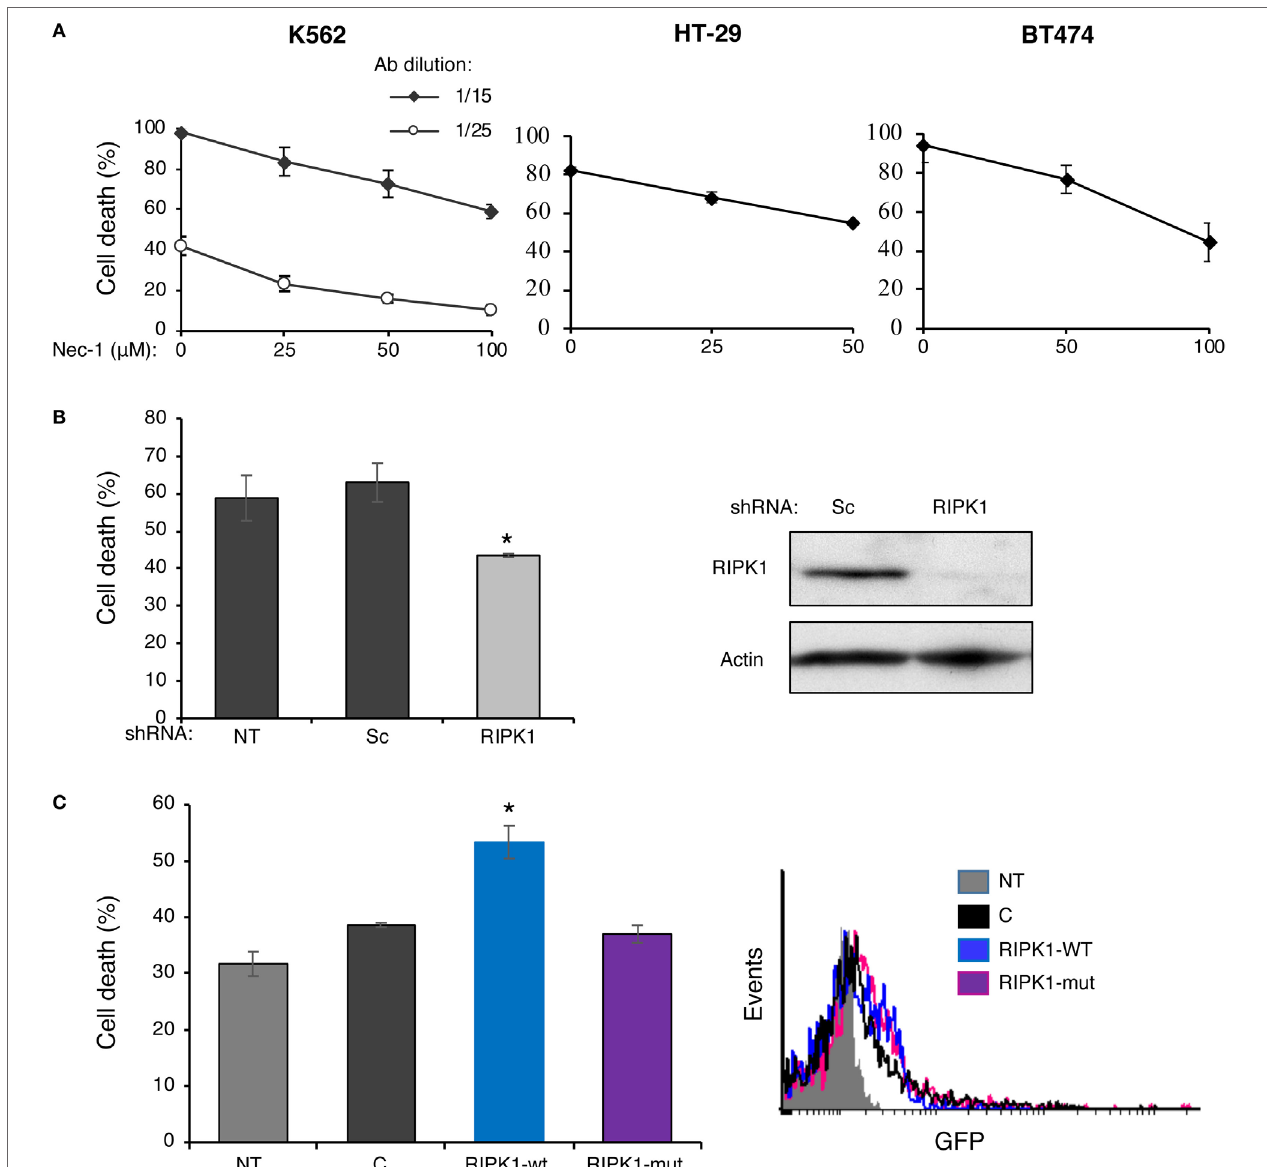
FigUre 1 | Complement C5b-9 induces receptor-interacting protein kinase 1 (RIPK1)-dependent necrosis. (a) K562, HT-29, or BT474 cells were treated with necrostatin-1 (Nec-1) or with DMSO (0) as control for 1 h at 37°C. Cell death (CD) by antibody (30 min at 4°C) and complement (1 h at 37°C) was performed as described under Section “Materials and Methods.” The experiment with K562 cells was performed with two antibody (Ab) dilutions. The percentage of CD was analyzed by propidium iodide inclusion. Results of three independent experiments are expressed as the mean percentage of CD ± SD. The percentage of CD by Nec-1, antibody, and HIS was 3–7% (negative controls). Statistical analysis showed that Nec-1 significantly inhibited CD (one-way-ANOVA, P < 0.01). (B) K562 cells transfected for 48 h with RIPK1-shRNA, a scrambled (Sc) shRNA, or not transfected (NT) were treated with antibody and complement and the percentage of CD was determined as described in panel (a) . Transfection with RIPK1-shRNA significantly inhibited the CD relative to the scrambled shRNA ( t -test, P < 0.01). The RIPK1 expression level (relative to actin) in the transfected cells was assessed by Western blotting analysis. A representative blot is shown. (c) K562 cells were transfected with the GFP-tagged plasmids: wild-type RIPK1 (RIPK1-wt), RHIM-ALAA mutant (RIPK1-mut), an empty vector control (C), or were NT. After 52 h, the cells were treated with antibody and complement and the CD was determined as above. Transfection with RIPK1-wt significantly enhanced the CD relative to empty vector and RIPK1-mut ( t -test, P < 0.01). Transfection efficiency was determined by analyzing the GFP expression by flow cytometry. A representative histogram is shown. All results represent three independent